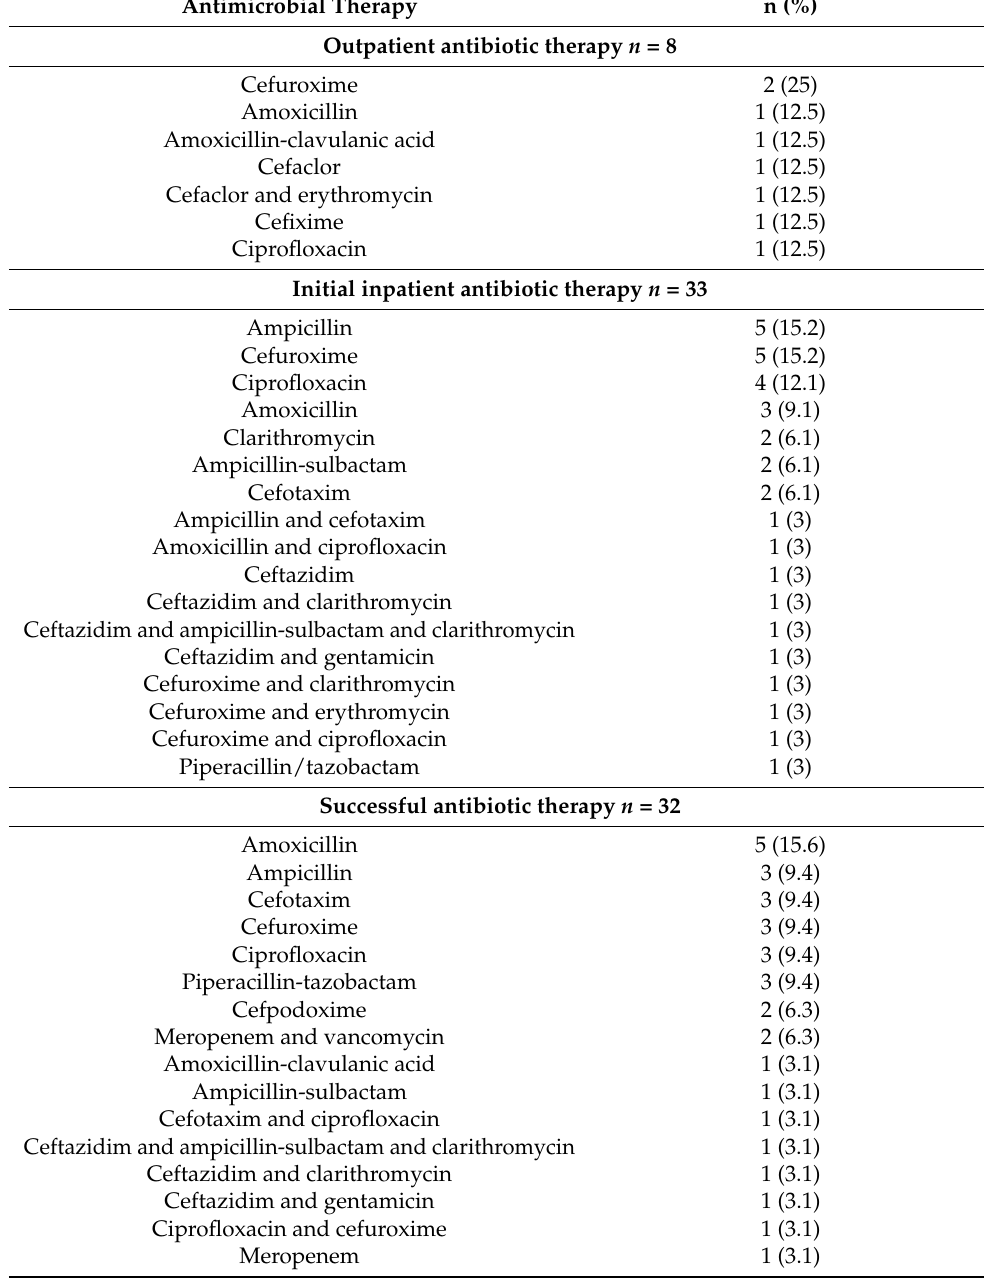
Table 3. Antimicrobial